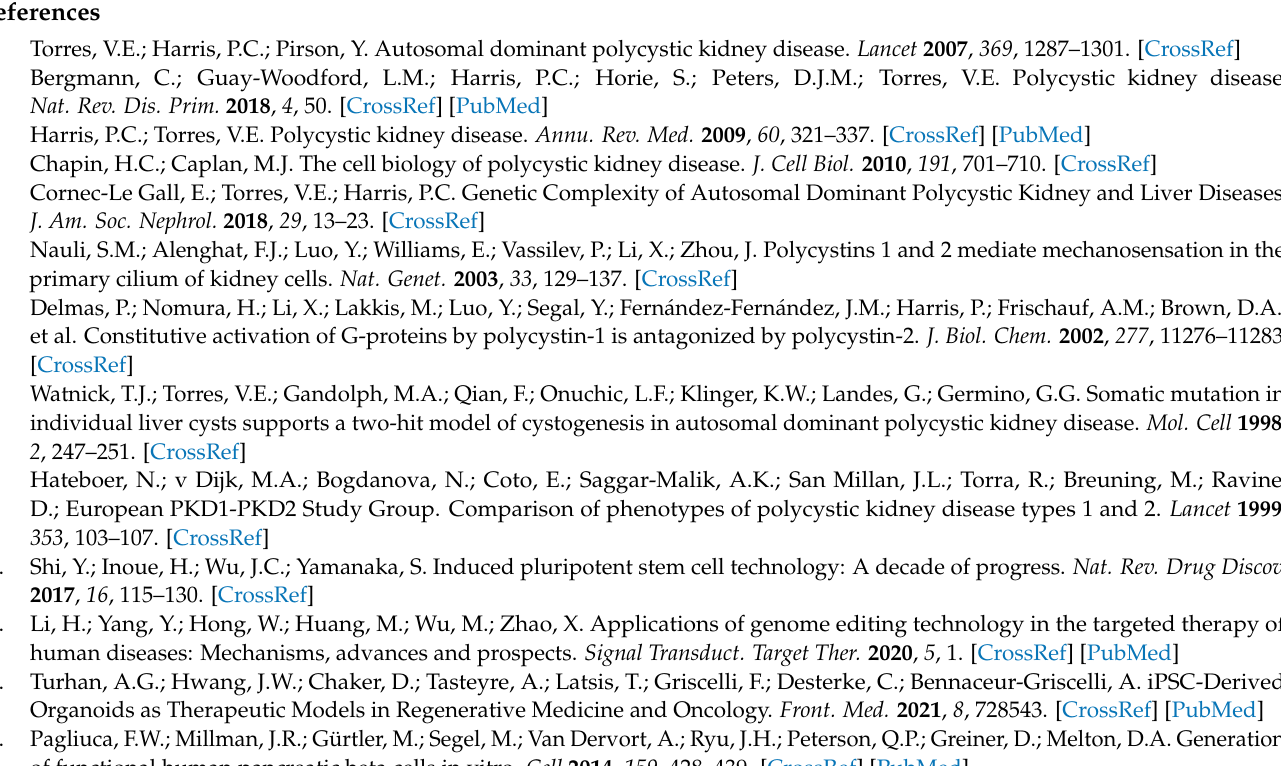
Table S1: List of primers; Table S2. List of